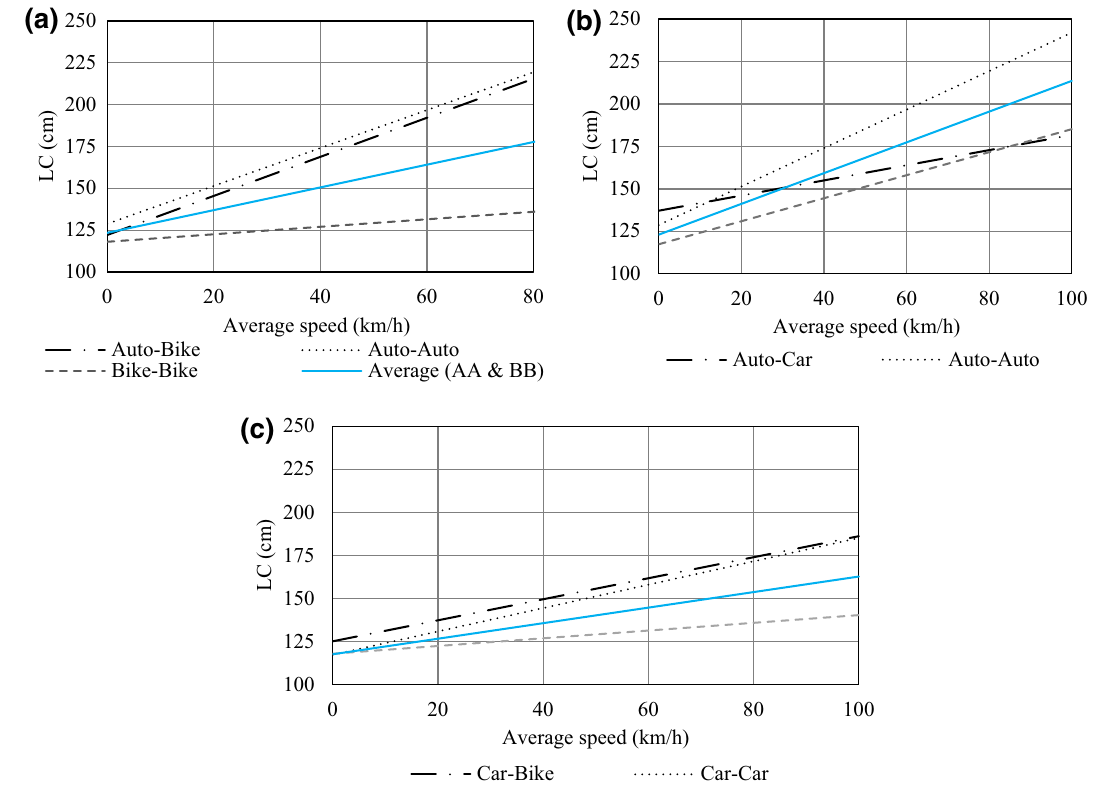
Fig. 9 Comparison of heterogeneous pair interaction with average of respective homogeneous pair interaction for auto–bike ( a ), auto–car ( b ) and car–bike interactions ( c